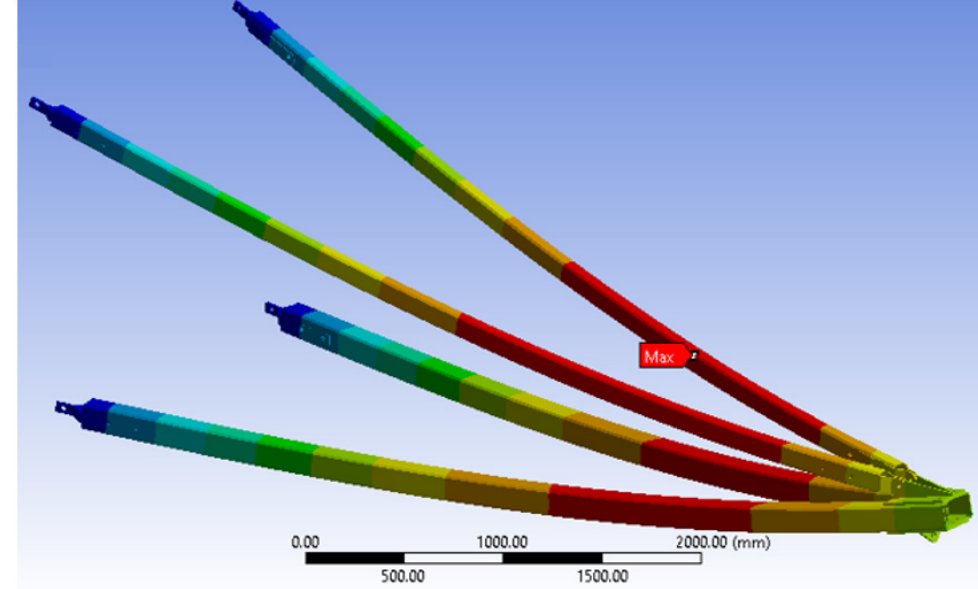
Figure 5. Typical deformed shape of GFRP cross ‐ arm.